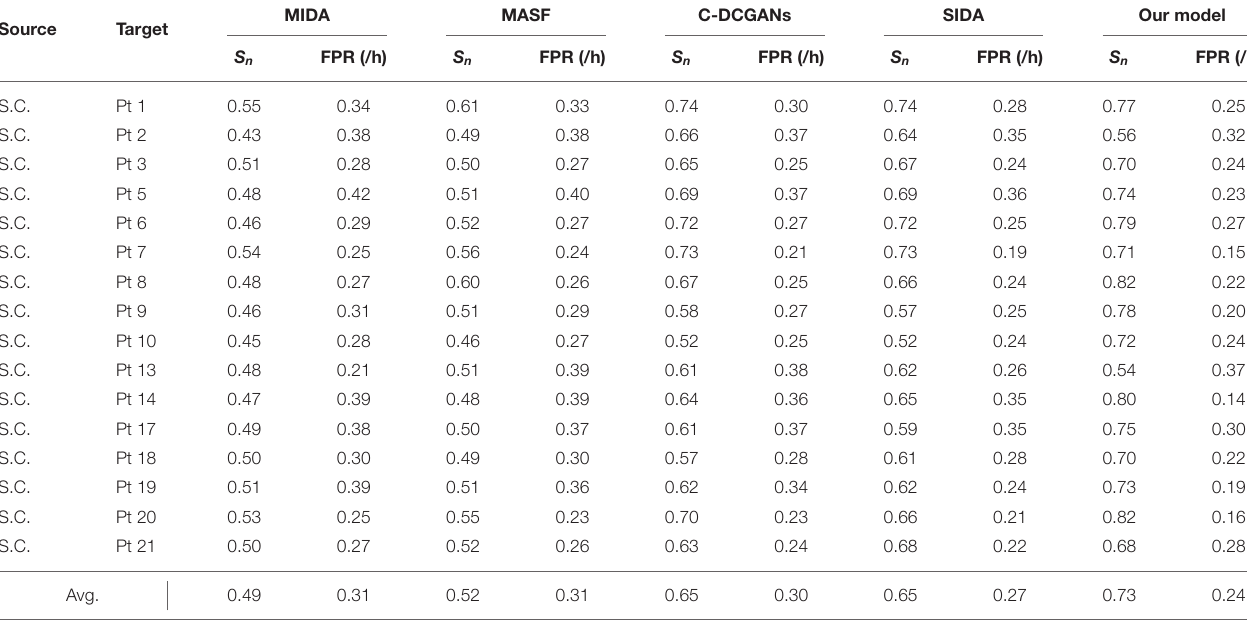
TABLE 6 | Results compared with DA methods on the CHB-MIT database.